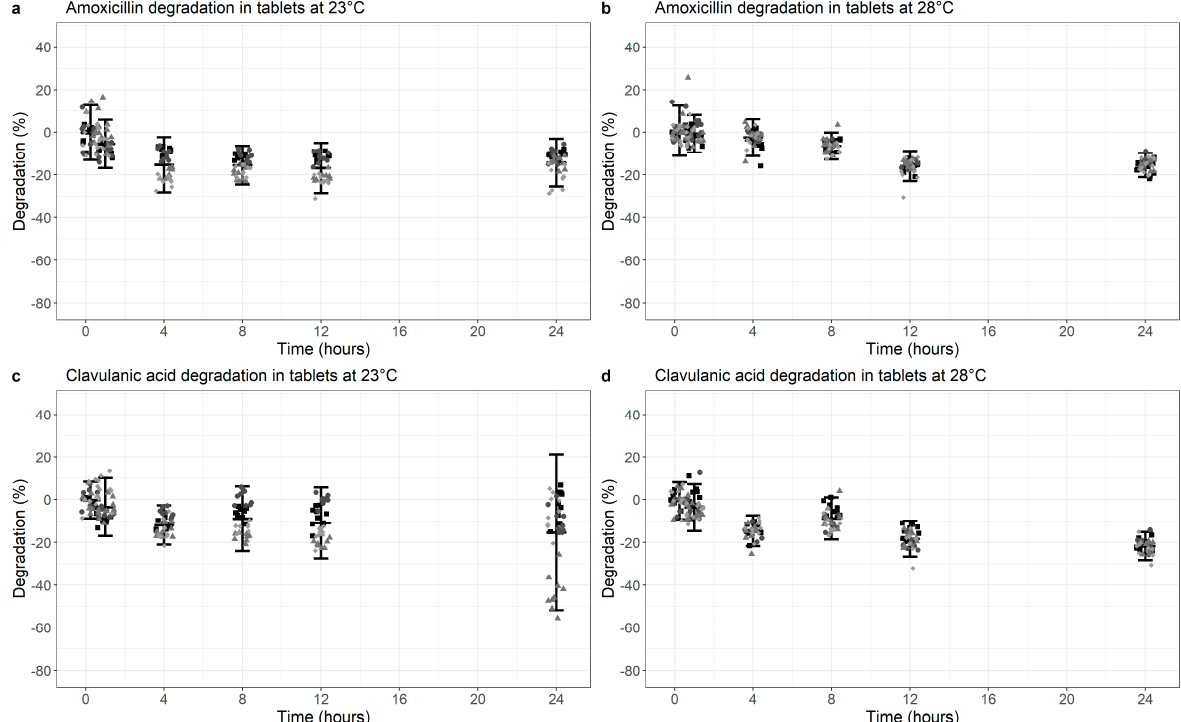
Figure 2. Degradation of Amoxicillin ( a , b ) and Clavulanic acid ( c , d ) at 23 °C ( a , c ) versus 28 °C ( b , d ) in co-formulated tablets (dissolved). Degradation is normalized for the median value at time point 0 (0% degradation). Data points represent the normalized individual measurements for Mepha 625 mg (square), Mepha 1000 mg (circle), Sandoz 625 mg (triangle) and Sandoz 1000 mg (diamond) tablets. Cross bar represents the mean and the whiskers indicate the 95% confidence interval (mean ± 2 SD) per time point.